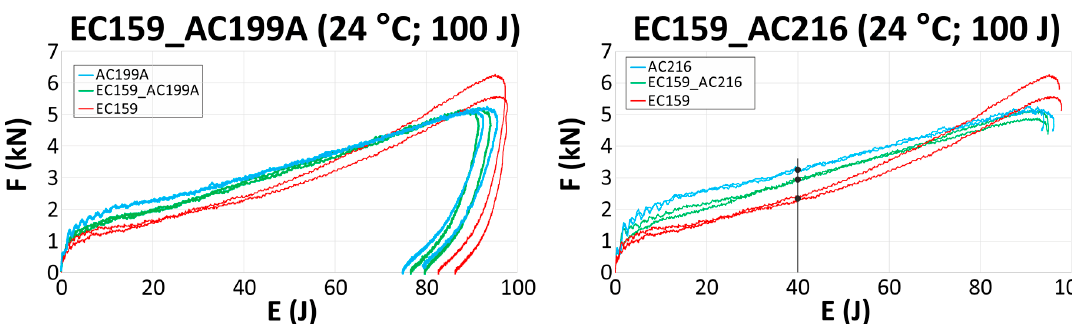
Figure 5. Force-energy curves of tested cork sandwiches.